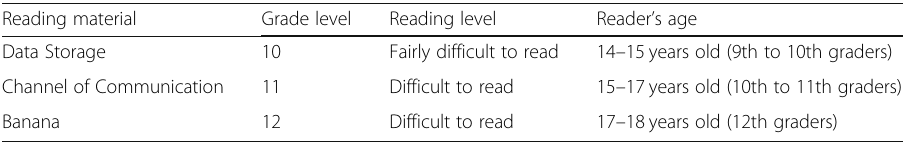
Table 3 Flesch Grade Level formula result for each material Reading material Grade level Reading level Reader ’ s age Data Storage 10 Channel of Communication